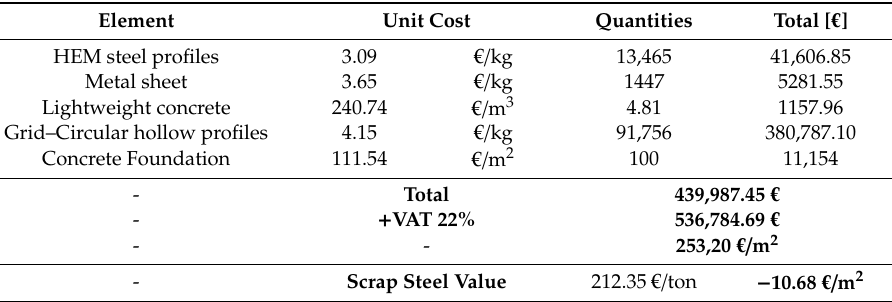
Table 4. Diagrid cost analysis